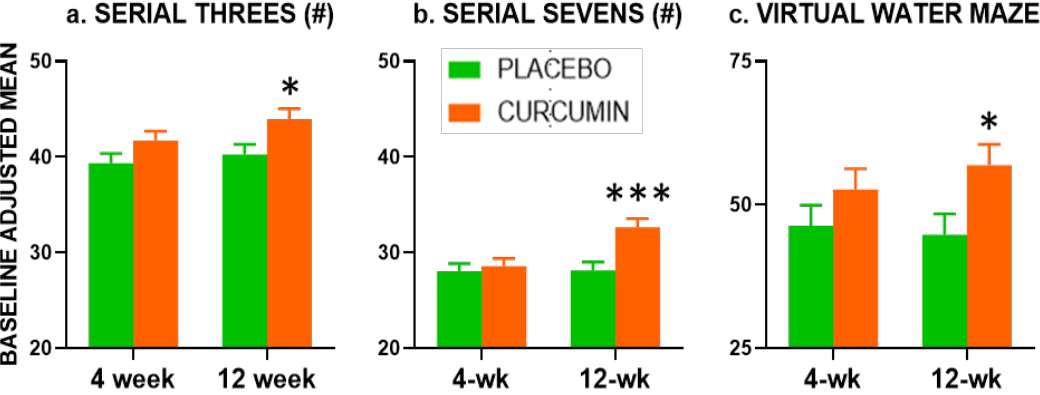
Figure 3. Positive effects of Longvida© on major cognitive outcomes. Graphs depict baseline adjusted means with Standard Error. Outcomes are number (#) correct for ( a ) Serial Threes and ( b ) Serial Sevens and time (t) in the target quadrant during the learning probe for ( c ) the virtual Morris Maze. *, p < 0.05; ***, p < 0.005.